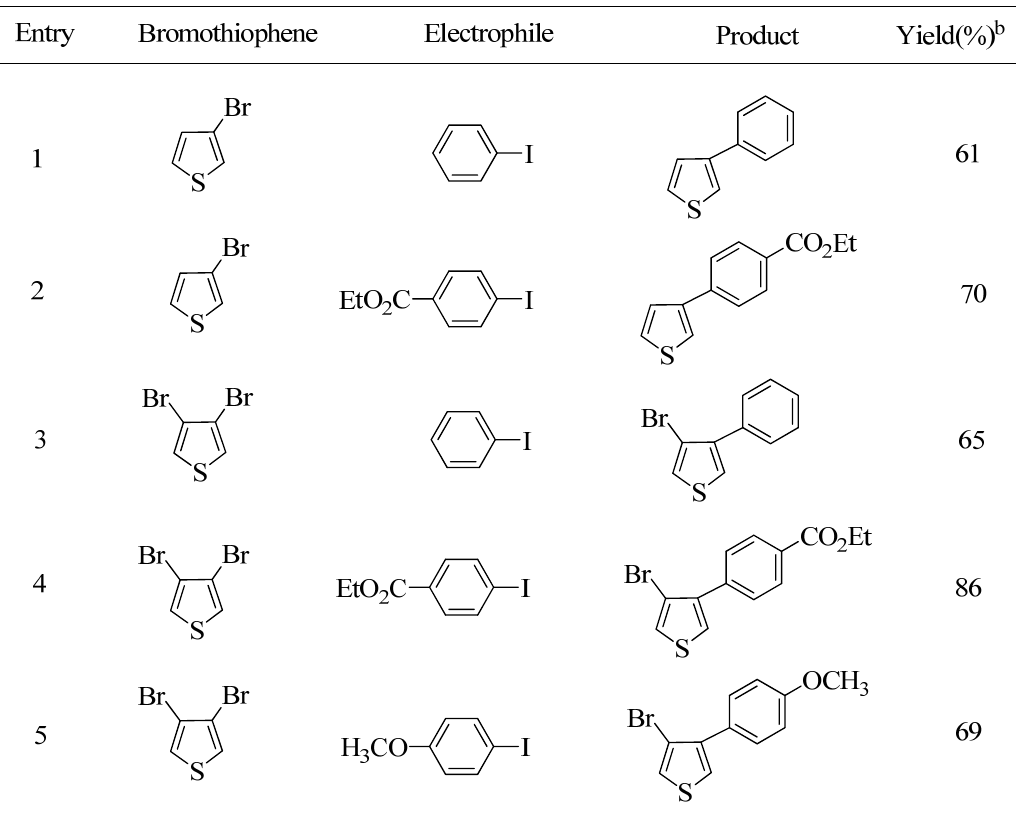
Table 18. Pd(0)-Catalyzed coupling reaction.